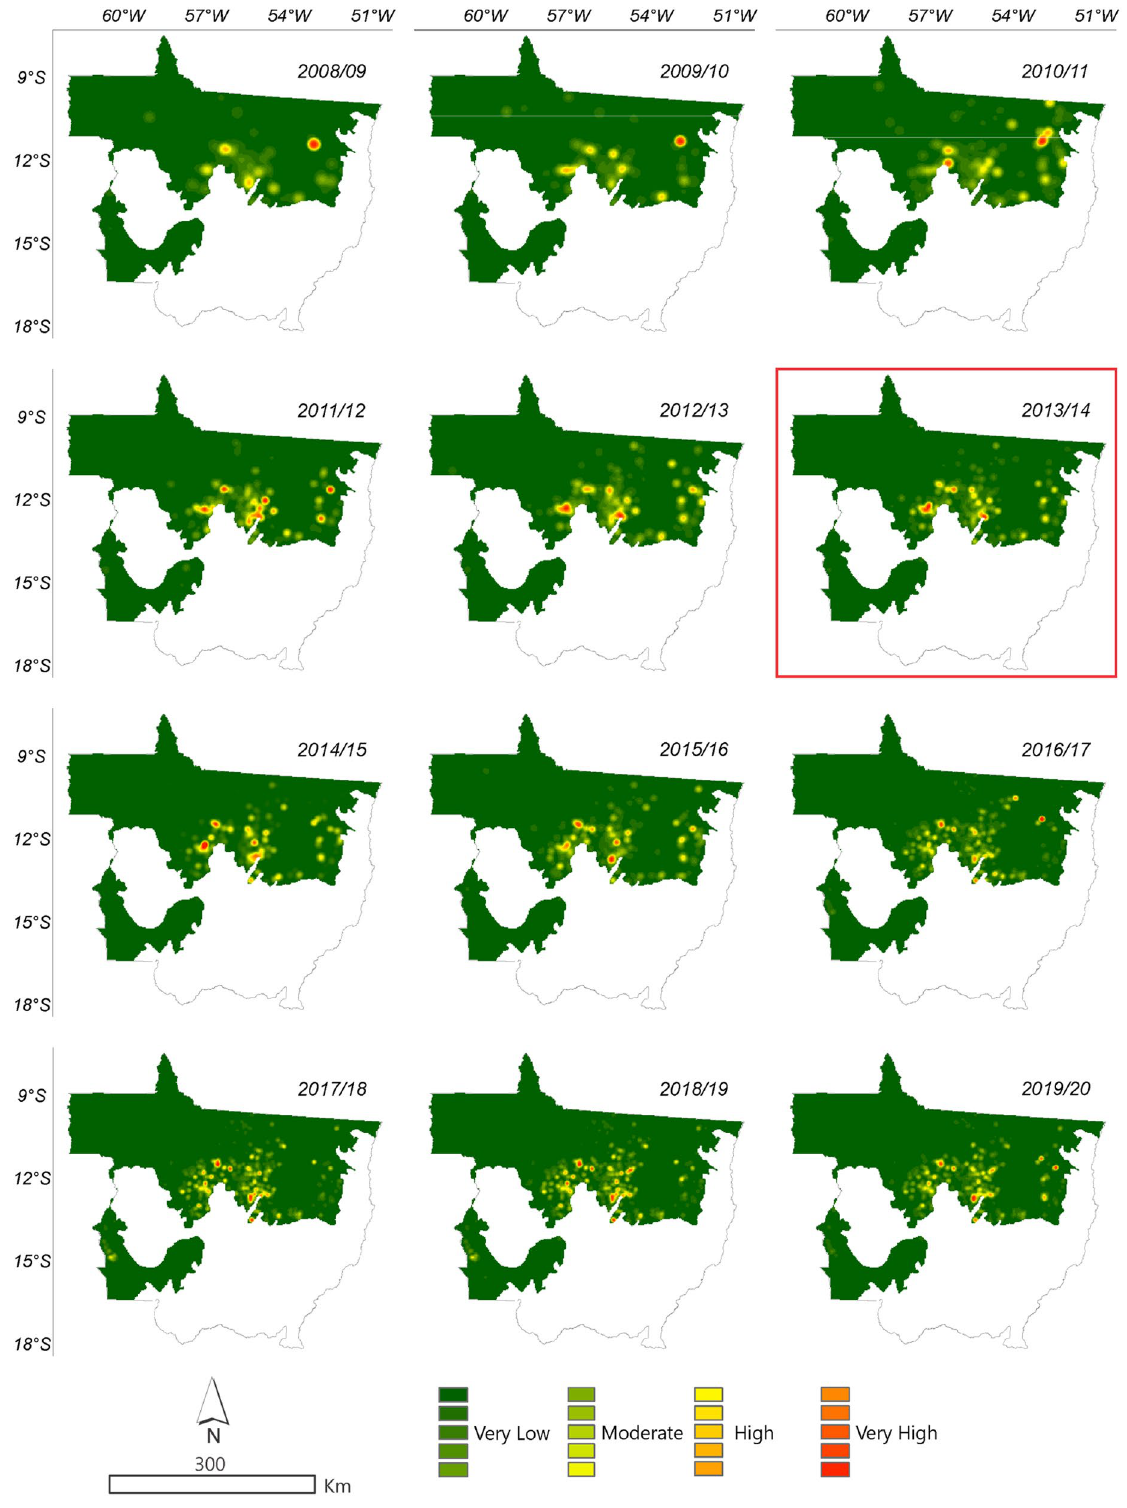
Figure 12. Density of deforestation caused by soybean in Amazonia biome in the State of Mato Grosso from 2008 to 2019 with data from PRODES. The year highlighted with red square corresponds to the likely point of change in the time series identified by the Pettitt test (Table